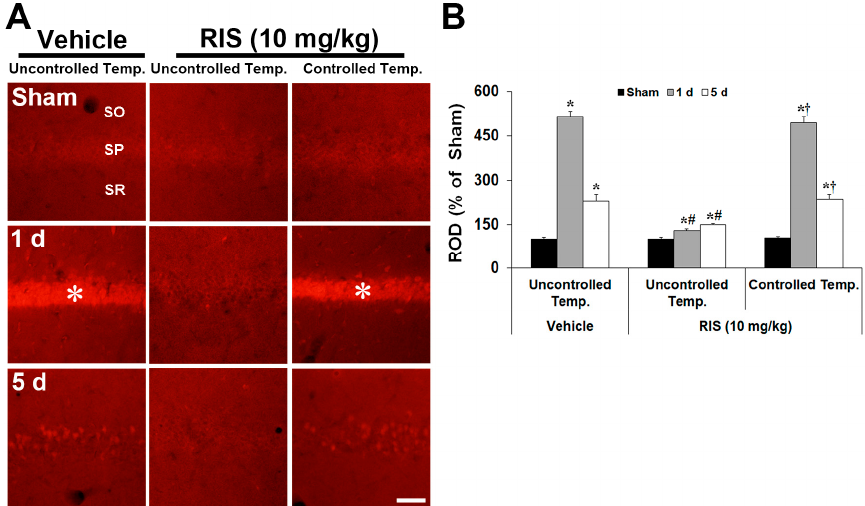
Figure 4. Effects of RIS on superoxide anion production after TI under UBT and CBT conditions. ( A ) Changes of DHE immunofluorescence in the CA1 after TI under UBT and CBT conditions. DHE immunofluorescence is significantly increased in CA1 pyramidal neurons of the stratum pyramidale (SP, asterisks) in the TI + vehicle group under UBT and TI + RIS group under CBT at 1 day after TI; however, DHE immunofluorescence is not significantly increased in the SP of the TI + RIS group under UBT condition. SO, stratum oriens; SR, stratum radiatum. Scale bar = 50 μ m. ( B ) Note analyses of DHE immunofluorescence in the SP. A ratio of the ROD is calibrated as %, with the sham + vehicle group designated as 100%. The bars indicate the means ± SEM, n = 7/group, two-way analysis of variance (ANOVA) with a post-hoc Bonferroni’s multiple comparison test (* p < 0.05 vs. sham + TI + vehicle group under UBT condition; # p < 0.05 vs. TI + vehicle group under UBT condition; † p < 0.05 vs. TI + RIS group under UBT condition.).